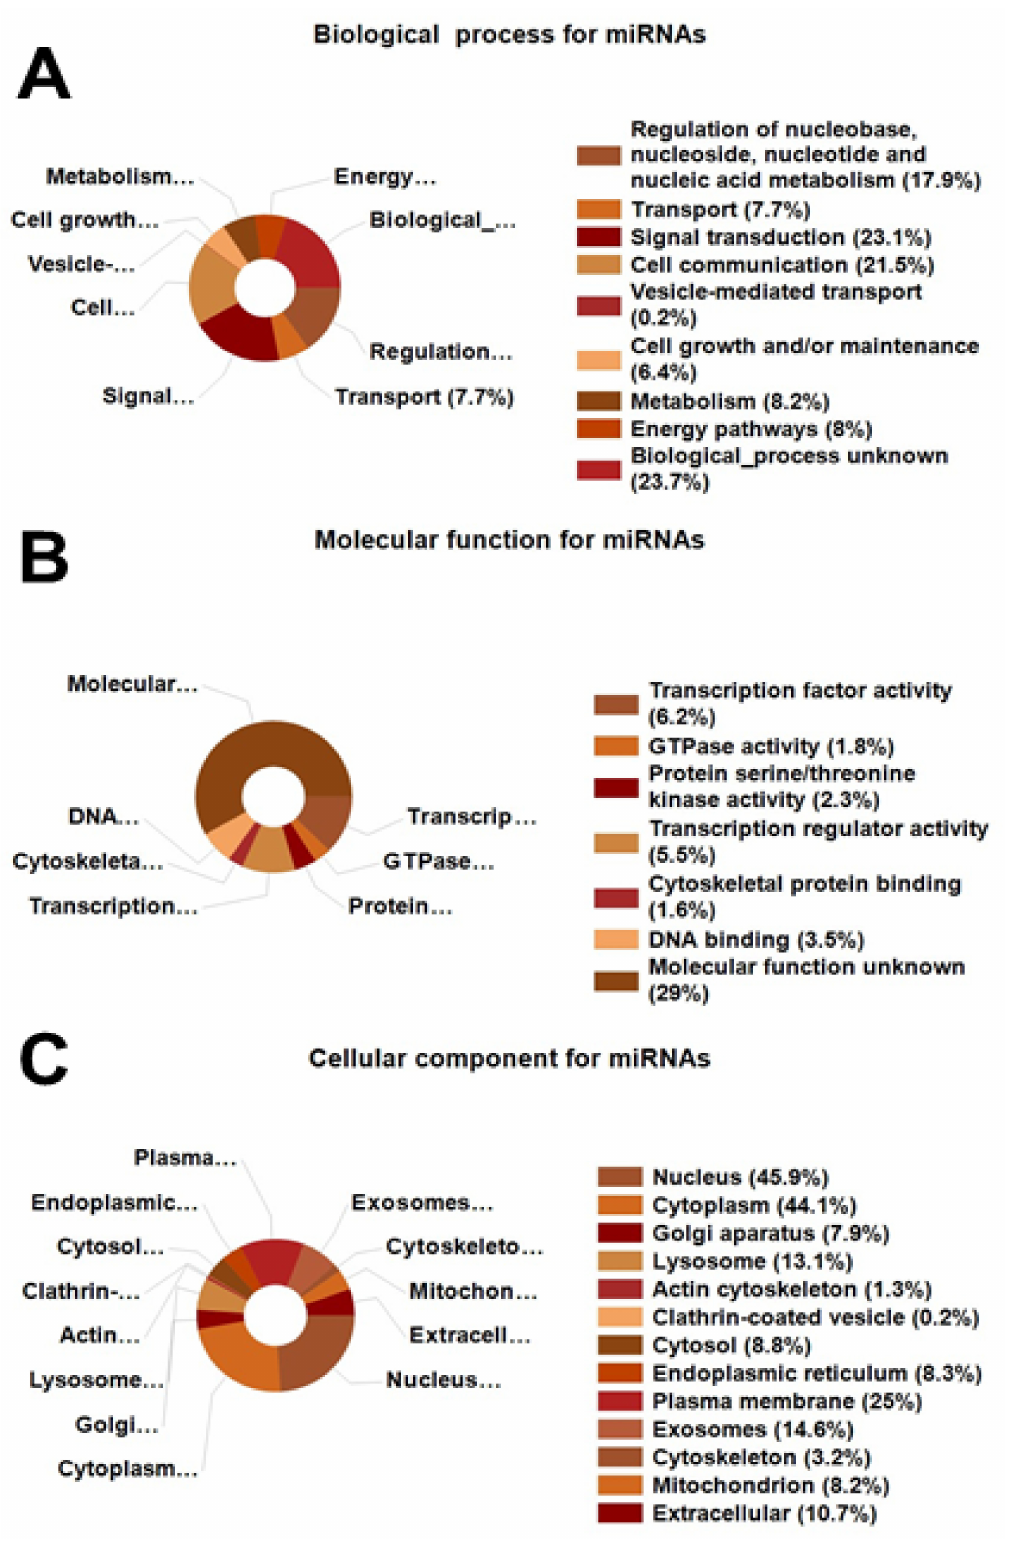
Figure 5. UniProt ID of the detected proteins reveals a total of 321 miRNAs through conversion by using FunRich miRNA enrichment tools. ( A ) shows miRNA enrichment based on UniProt ID protein’s conversion characterized on their biological process, ( B ) their molecular function, and ( C ) their cellular